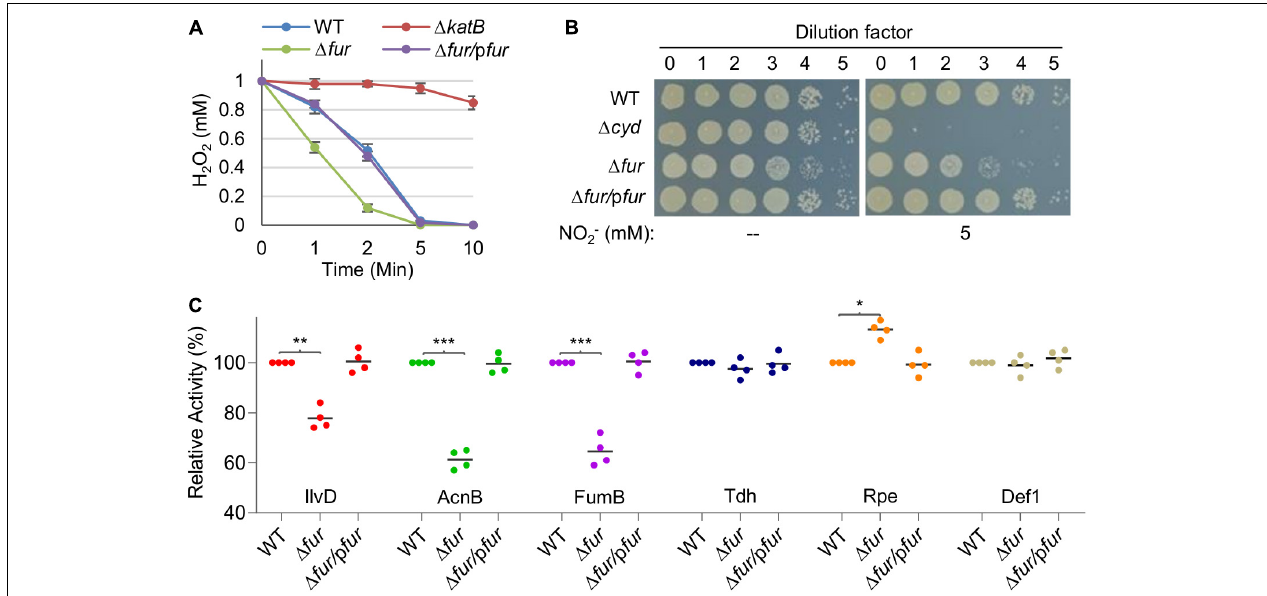
FIGURE 3 | The Fur loss affects activity of iron-proteins differently. (A) Activity of heme protein catalase determined by H 2 O 2 (1 mM) decomposition assay. Cells of indicated strains grown to the mid-exponential phase were collected and adjusted to the same OD values. An aliquot of 200 µ l was mixed with H 2 O 2 and the remaining amounts were determined at indicated times. WT, the wild-type. (cid:49) fur/ p fur , the fur null mutant is complemented with a copy of the fur gene in trans . A mutant lacking catalase KatB, which dictates H 2 O 2 scavenging capacity of S. oneidensis , was used as the negative control. (B) Activity of heme protein cyt bd oxidase determined by nitrite susceptibility with droplet assays. Cultures at the mid-exponential phase prepared to contain approximately 10 8 cfu/ml were regarded as the undiluted (dilution factor, 0), which were subjected to 10-fold serial dilution. Five microliters of each dilution was dropped on agar plates with nitrite at indicated concentrations. Results were recorded after 24 h incubation. (C) Activity of Fe-S and mono-nuclear proteins determined by respective enzymatic assays. Enzymes included dihydroxy-acid dehydratase (IlvD, 2Fe-2S), aconitase (AcnB, 4Fe-4S), fumarase (FumB, 4Fe-4S), threonine dehydrogenase (Tdh, mono-), ribulose 5-phosphate 3-epimerase (Rpe, mono-), and peptide deformylase (def1, mono-). The activity of each enzyme in the wild-type was set to 100%. Asterisks indicate statistically significant difference of the value compared to that of WT (* P < 0.05; ** P < 0.01; *** P < 0.001). Experiments were performed at least three times, and data were presented as means ± SEM or as values representative of similar